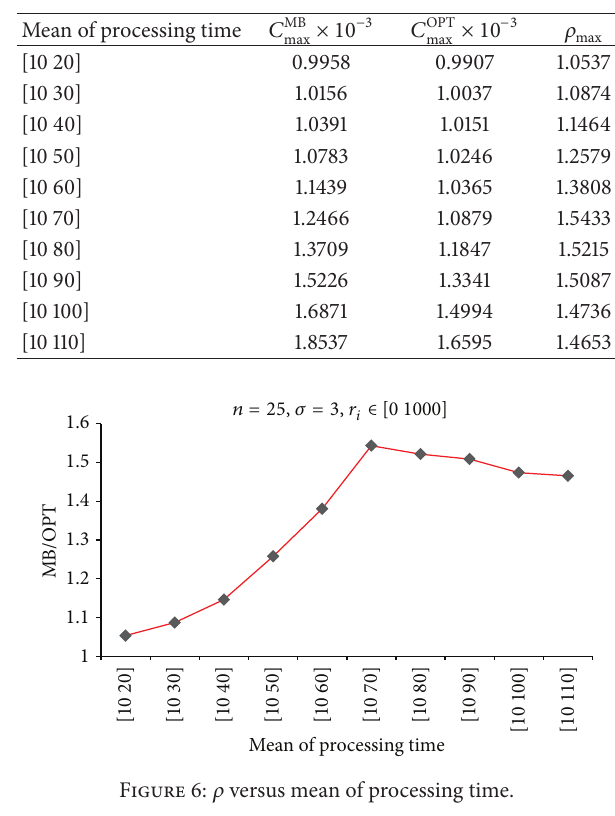
Table 4: Makespan value of the proposed algorithm versus lower bound of optimum.